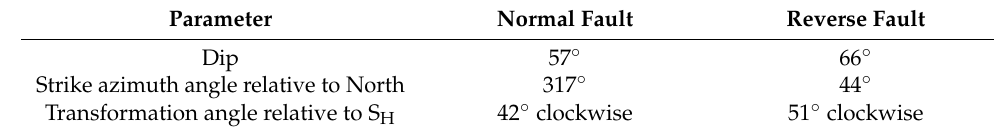
Table 1. Geometrical parameters of the examined faults based on Markou and Papanastasiou [13].